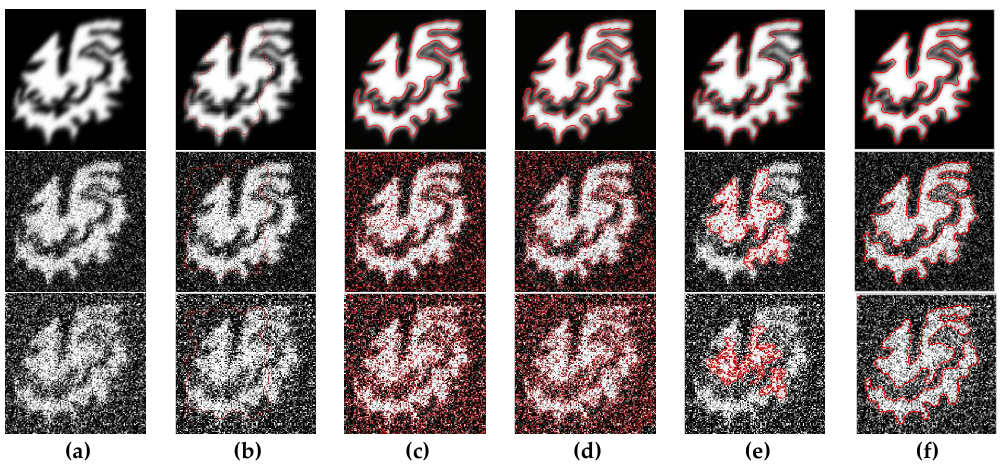
Figure 5. Comparisons of the five models in segmenting noisy images: (a) The original image; (b) The segmentation results of the DRLSE model; (c) The segmentation results of the LBF model ; (d) The segmentation results of the LIF model ; (e) The segmentation results of the LSACM model ; (f) The segmentation results of the IRLS-IS model .